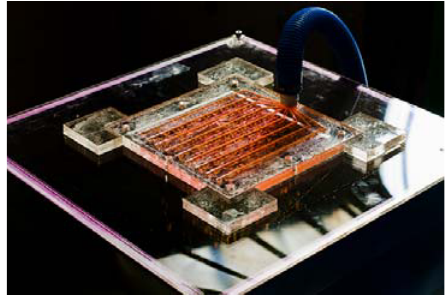
Fig. 3. Droplet generator made from the plexiglass